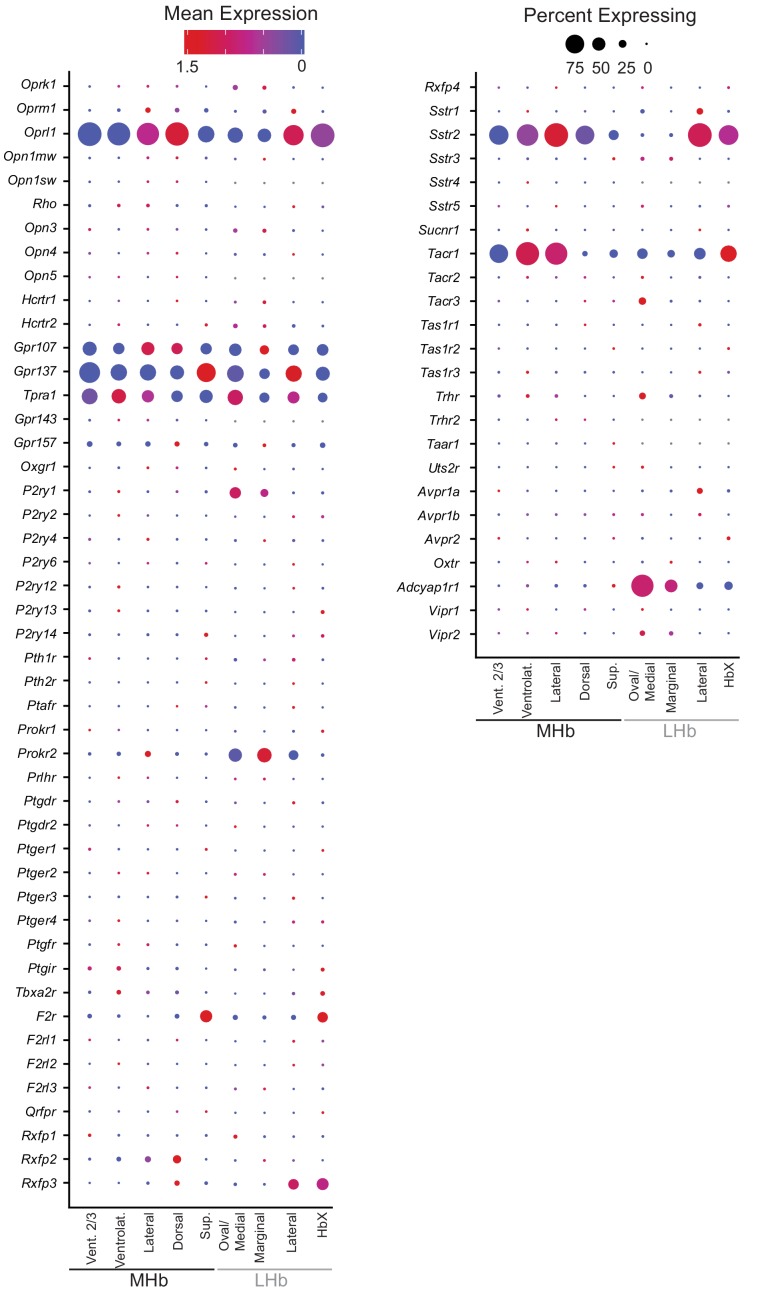
GPCR diversity in MHb and LHb neuronal subtypes (part 4).Dot plot displaying gene expression of all GPCRs detected in MHb and LHb neurons (Harding et al., 2018; Regard et al., 2008). Genes are grouped and listed alphabetically by receptor family name (Adenosine Receptors, Somatostatin Receptors, etc.). The color of each dot (blue to red) indicates the relative expression of each gene whereas the dot size indicates the fraction of cells expressing the gene.